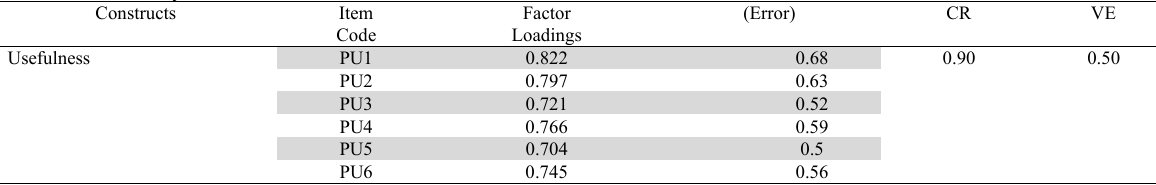
Construct reliability and variance